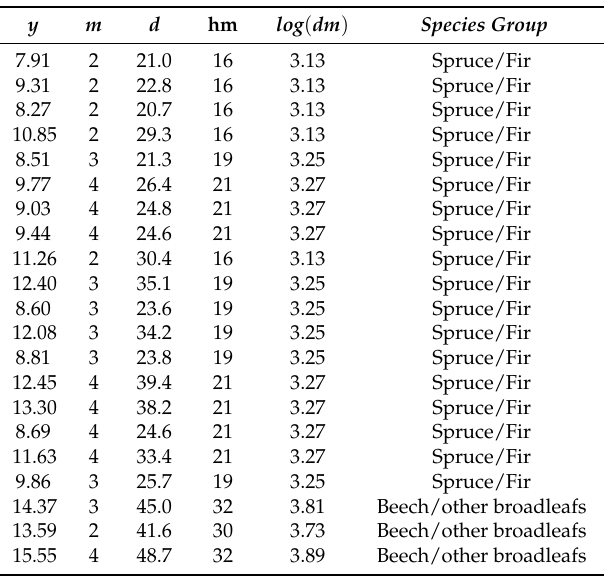
Table A1. Model data sample plot 12. 𝑦 is the transformed tree height; 𝑚 — 𝑆𝑝𝑒𝑐𝑖𝑒𝑠 𝑔𝑟𝑜𝑢𝑝 are the covariates of the